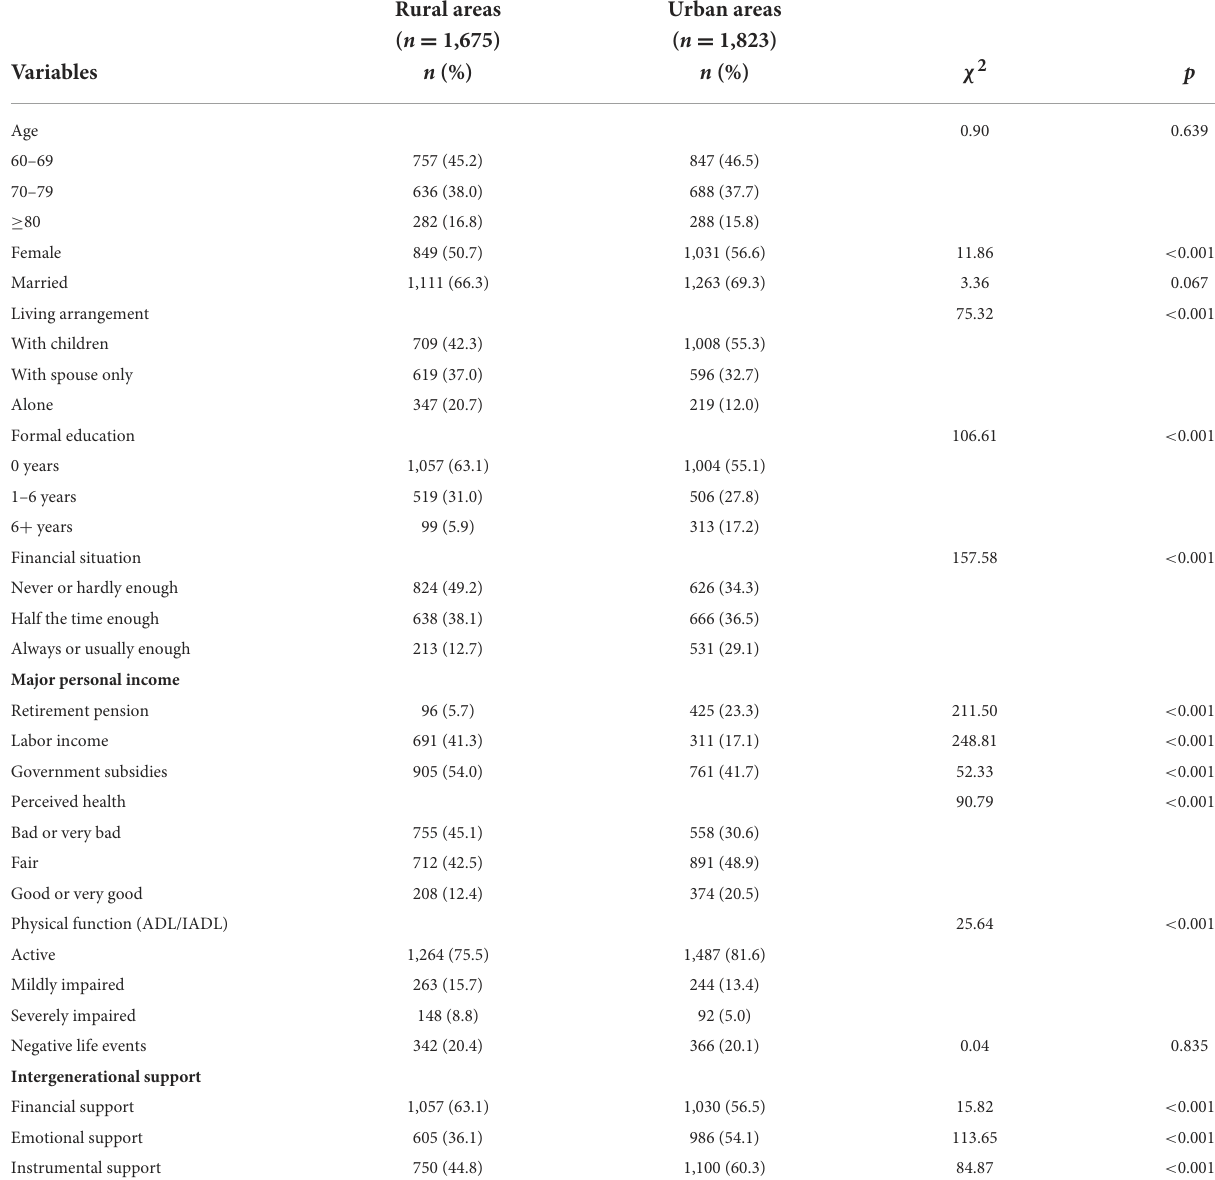
TABLE 1 Sociodemographic characteristics of participants in the two areas. Rural areas Urban